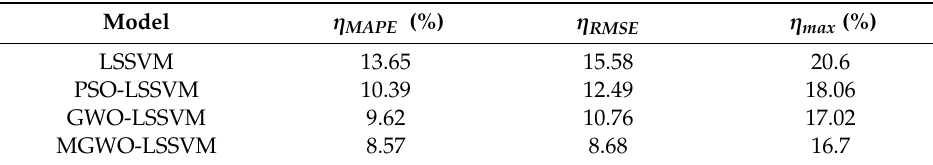
Table 7. Comparison of di ff erent prediction models.